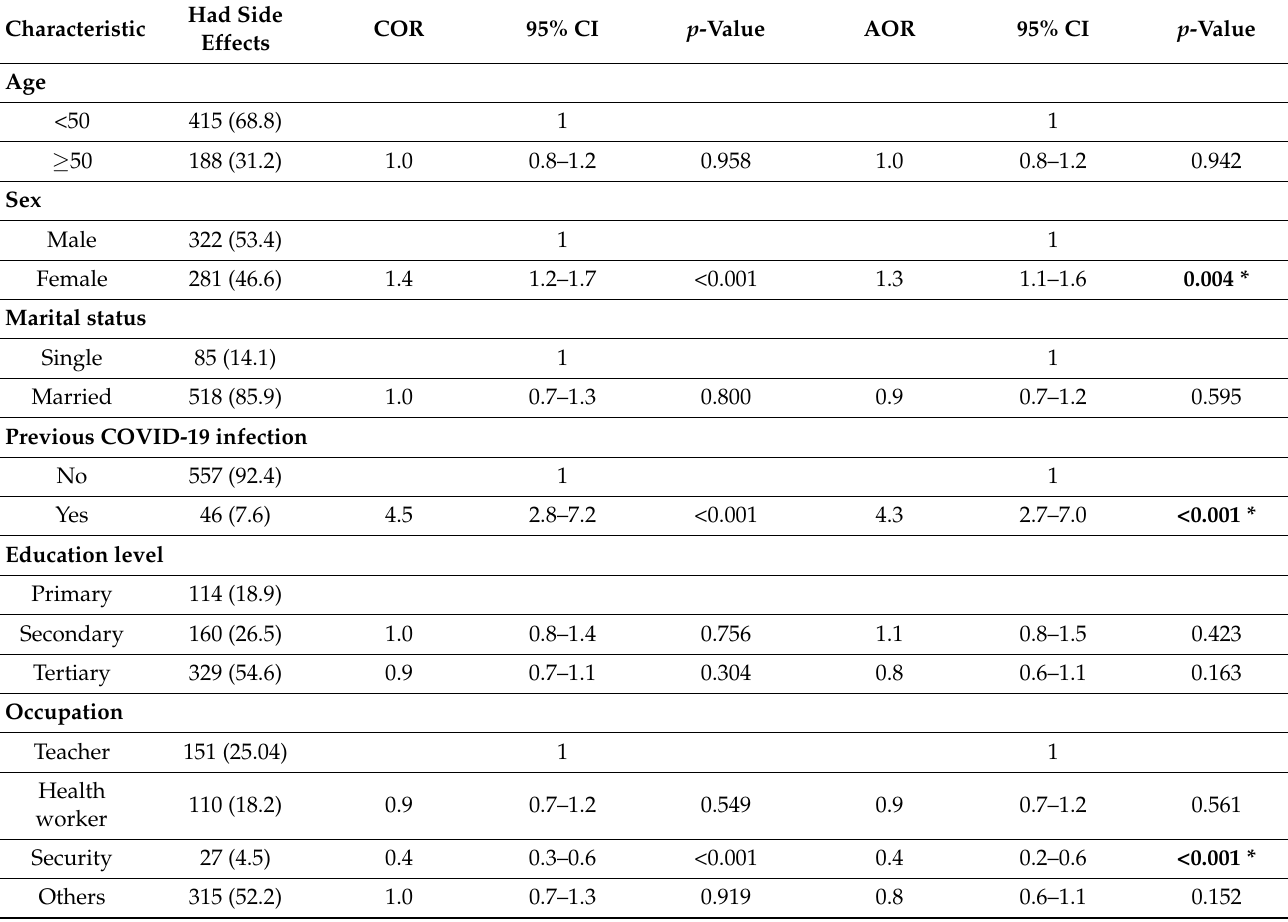
Table 5. Factors associated with experiencing side-effects of Oxford/AstraZeneca